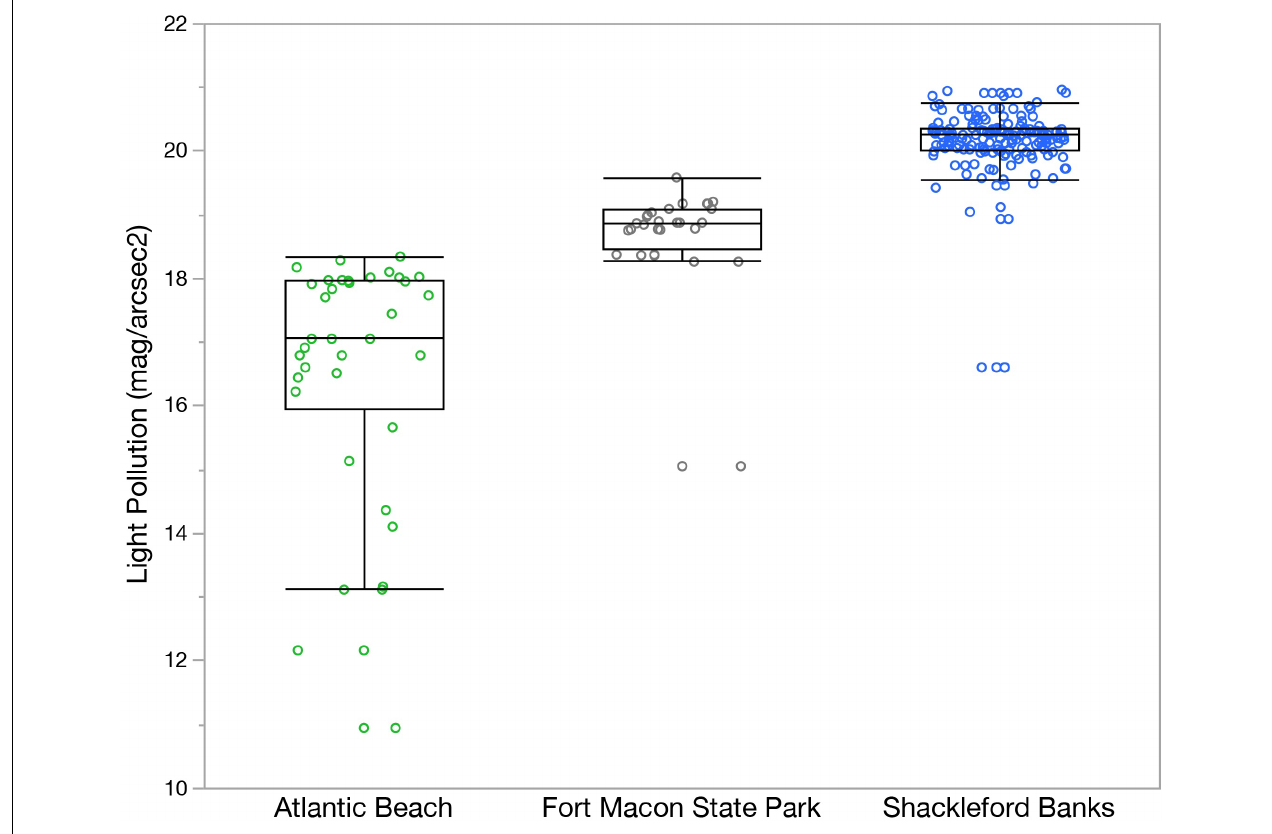
FIGURE 4 | Significantly different mean ( + / − SD) light pollution values (mag/arcsec 2 ) at each nest location at Atlantic Beach, Fort Macon State Park, and Shackleford Banks, NC (One-Way ANOVA, p < 0.0001). Dots represent light pollution value at each nest.